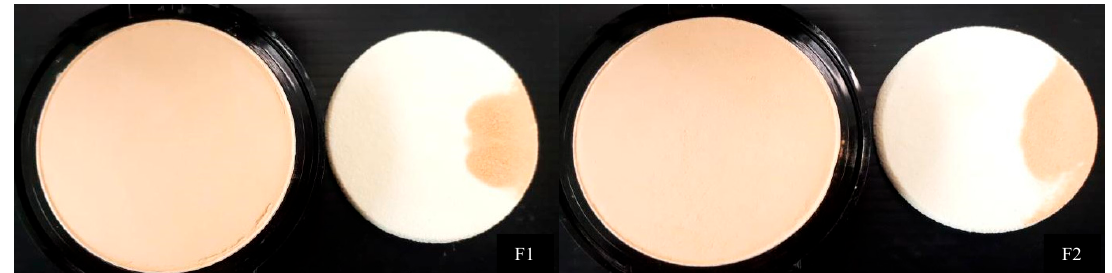
Figure 5. The appearance of the puffs for the pay-off test: the talcum compact powder (F1) and rice flour replaced talcum (F2).